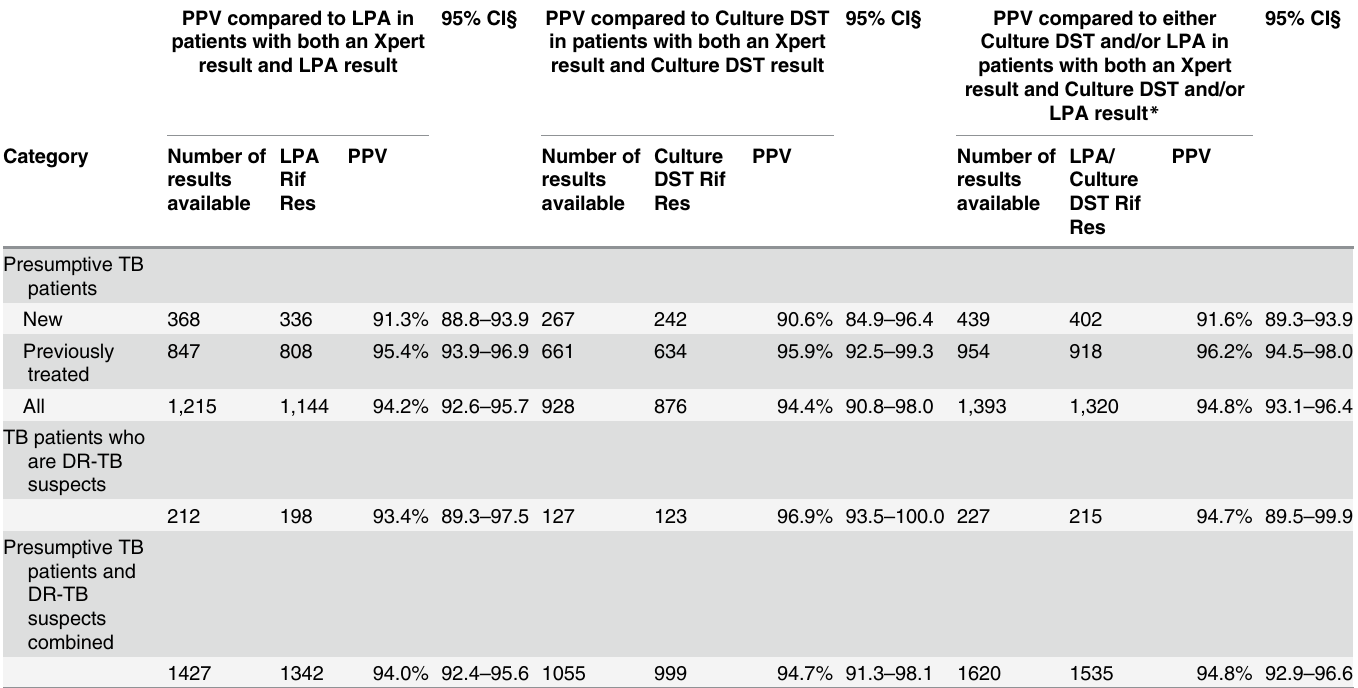
* If results are available for both phenotypic DST and LPA, a rifampicin resistance result on at least one of those is considered as con fi rmatory § Adjusted for clustering at site level using robust standard